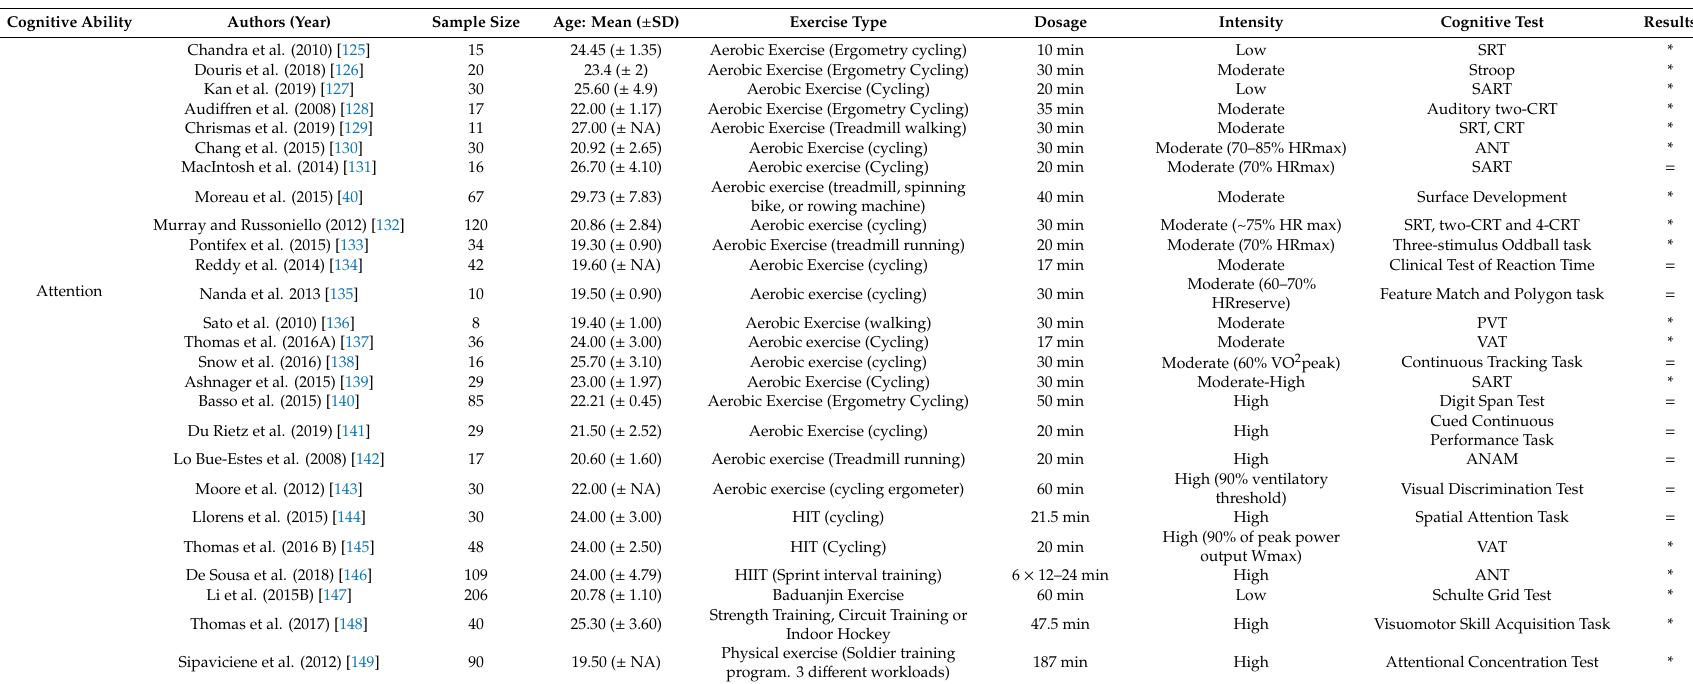
19.50 ( ± NA) Physical exercise (Soldier training program. 3 di ff erent workloads) 187 min High Attentional Concentration Test